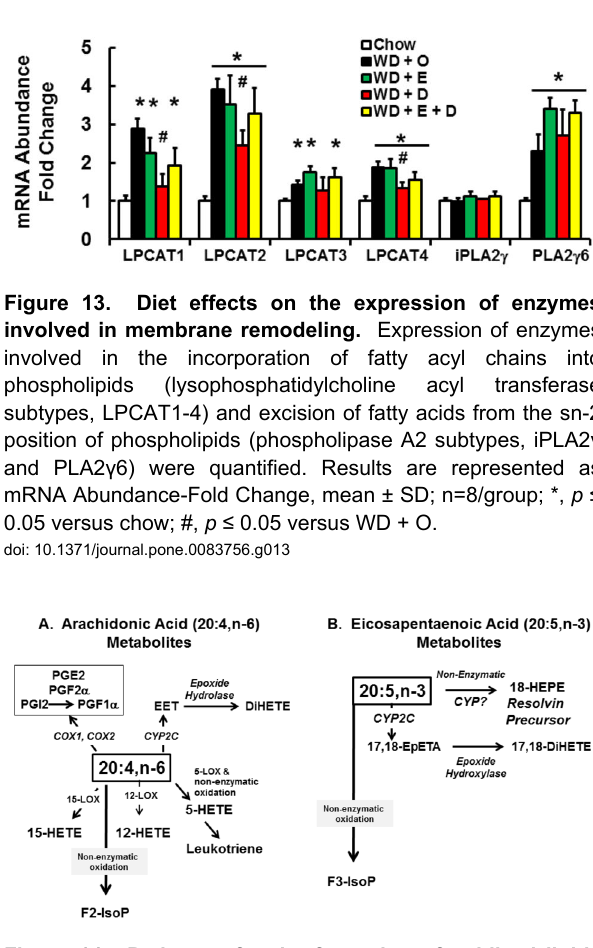
hydroxyeicosatetraenoic acid (HETE) are LOX products derived from 20:4,n-6. The WD + D diet was the most effective diet at suppressing WD-mediated accumulation of oxidized lipids derived from n-6 PUFA.